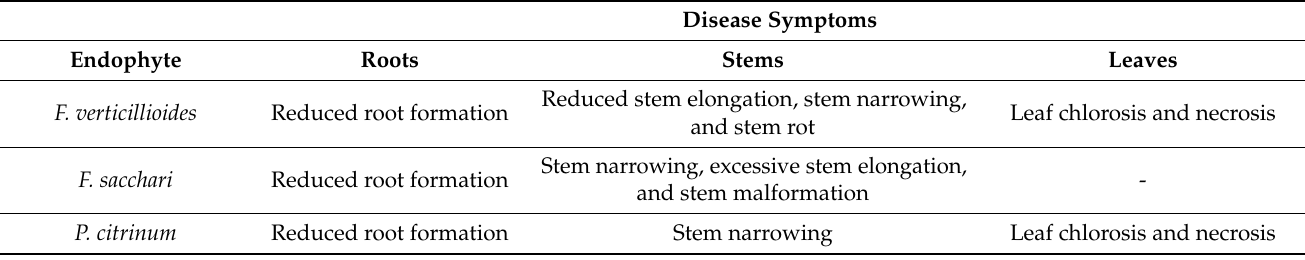
Table 2. The disease symptoms initiated by endophytic fungi in infected corn